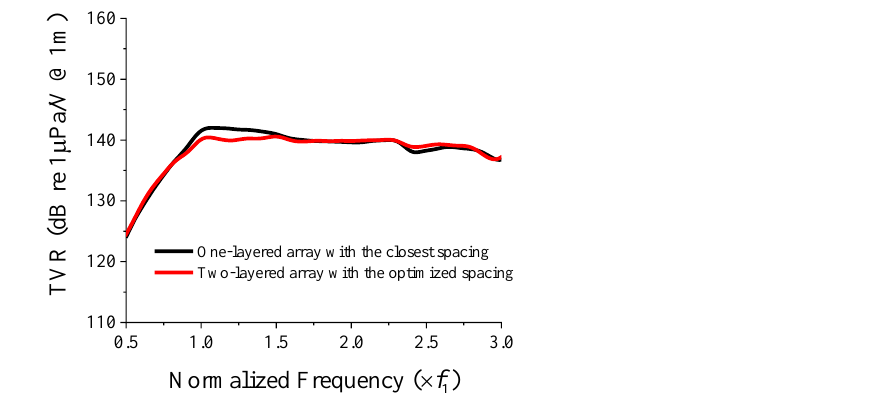
Figure 15. Comparison of the TVR spectrum of the one-layered 3 × 3 array with the closest spacing and that of the two-layered array with the optimized CTC spacing. Table 4. Comparison of acoustic characteristics of one- and two-layered cymbal arrays.